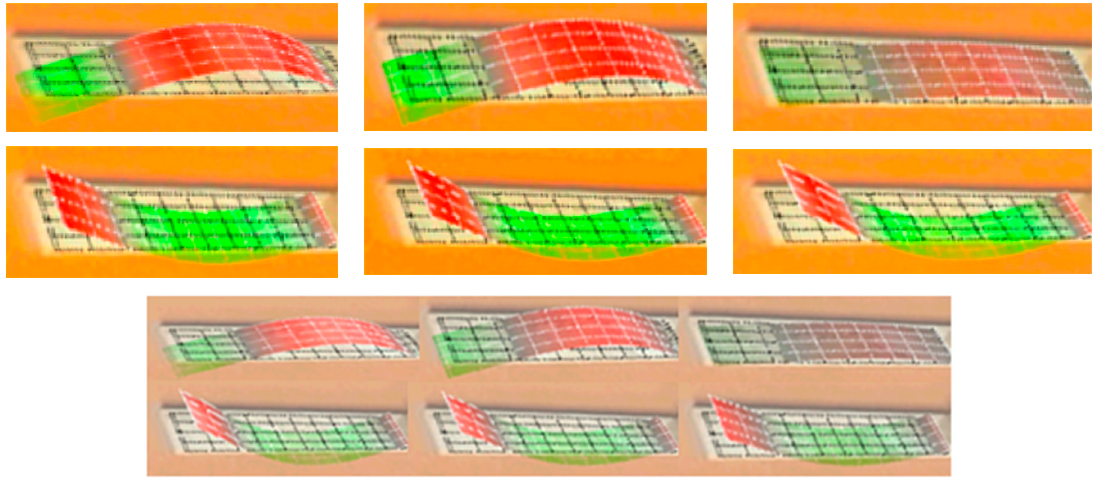
Figure 16. Image of the vibration dynamic diagram.